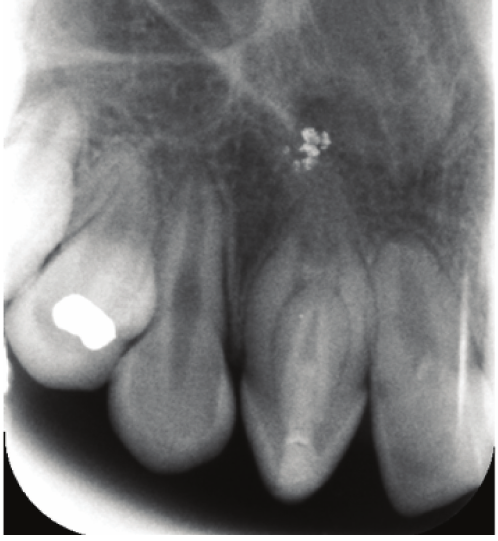
Figure 2: The one-year follow-up radiograph showing complete healing of the periapical lesion.